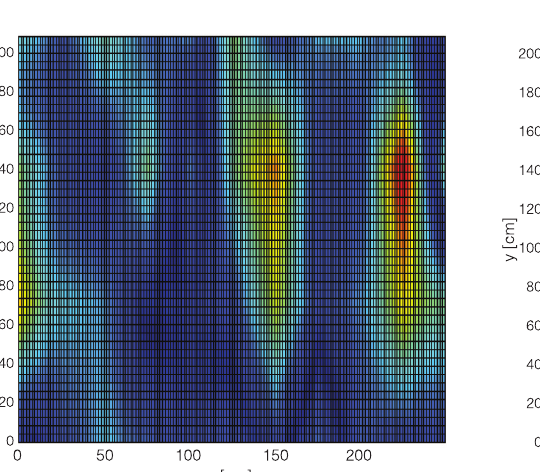
Fig. 14. Horizontal slice at 15 ns under the Roman road (square A).